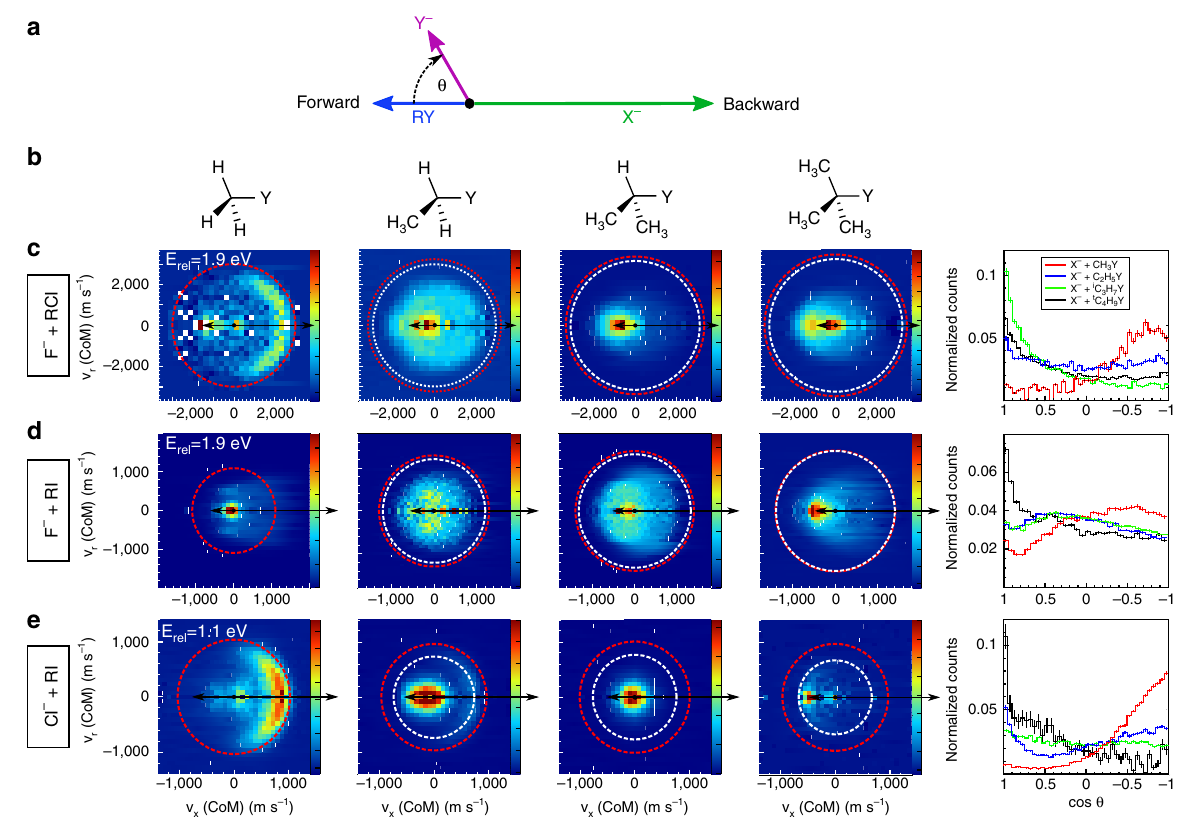
Fig. 2 Experimental centre-of-mass product velocity and scattering angle distributions. a Scheme illustrating the directions and velocities of the rectants in the centre of mass frame and de fi ning forward and backward scattering, as well as the scattering angle θ . b Chemical structures of the neutral reactants. c – e Velocity map images for four reactions of type X − + RY (R = CH 3 , C 2 H 5 , i C 3 H 7 , t C 4 H 9 ): c : F − + RCl; d : F − + RI; e : Cl − + RI. Each histogram consists of a sum of about 50,000 product ion events. For each nucleophile-leaving group combination, the right panel illustrates the corresponding scattering angle distribution as function of methyl substitution of the neutral reactant, where the error bars depict the wighted statistical errors for each histogram bin. A clear transition from backward to forward scattering dynamics is observed in all three cases. The energetic limits for the S N 2 and E2 channels are marked by red and white dashed circles, respectively. The experimental result for F − + CH 3 Cl (upper left image) has been adapted from a